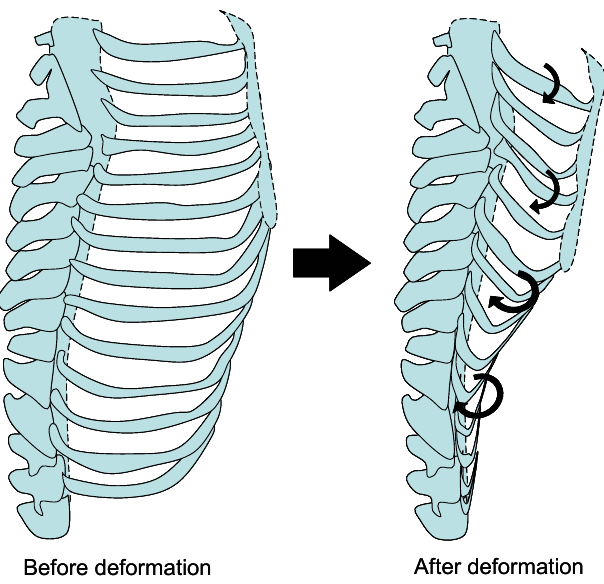
Fig. 13 Transformation behavior of the thorax during compression from the front. The thorax is transformed primarily by costovertebral joints changing their